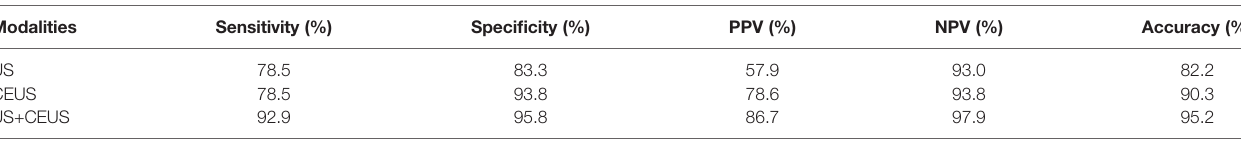
TABLE 3 | Diagnostic performance of US, CEUS, and US combined CEUS for LNM from PTC. Modalities